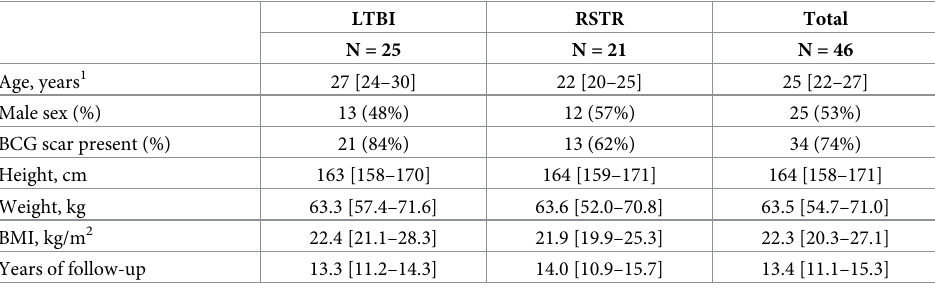
Table 1. Characteristics of study